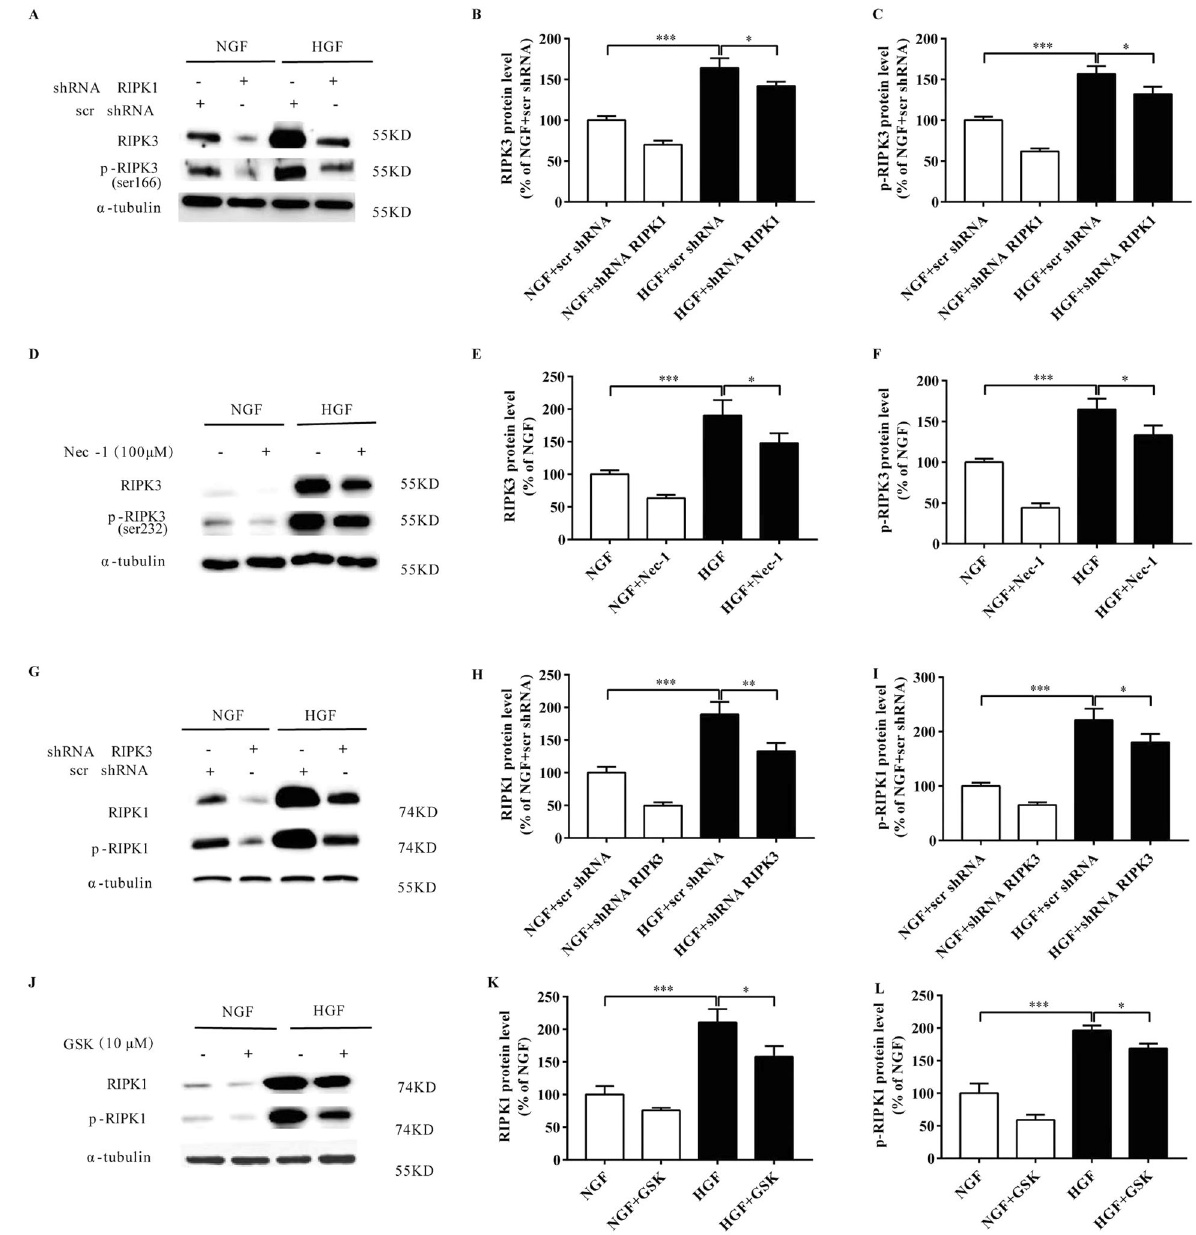
Fig. 4 RIPK1/RIPK3 inhibition represses respectively RIPK3/ser232-p-RIPK3 or RIPK1/ser166-p-RIPK1. Representative images and percentages of RIPK3 and ser232-p-RIPK3 ( A - F ); Representative images and percentages of RIPK1 and ser166-p-RIPK1 ( G - L ). n = 3 per group. Means ± SD. * P < 0.05, ** P < 0.01, *** P < 0.001. NGF normal glucose and fat group, HGF high glucose and high fat group, Nec-1 necrostatin − 1, GSK